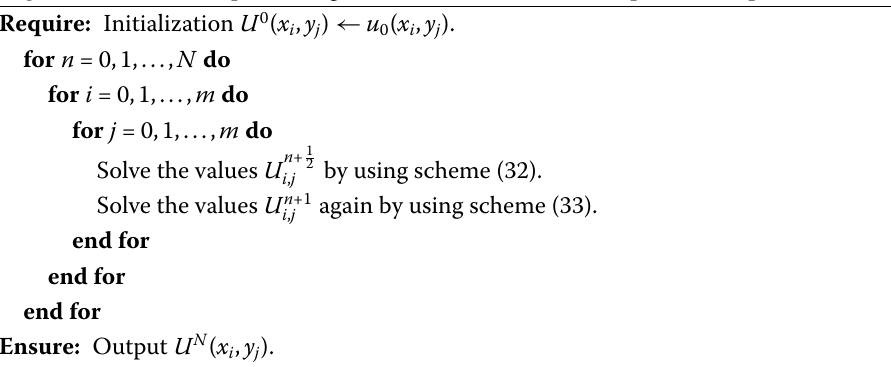
Algorithm 2 The new parallel algorithm for two-dimensional parabolic